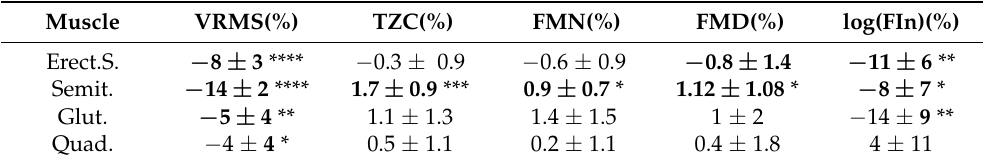
Table 1. Percentage of variation in EMG variables caused by exoskeleton, together with their confidence interval for a sample size of 768 and a level of confidence of 95%. Values with significant differences are show in bold, with p -values below 0.05. *: p ≤ 0.05, **: p ≤ 0.01, ***: p ≤ 0.001,****: p ≤